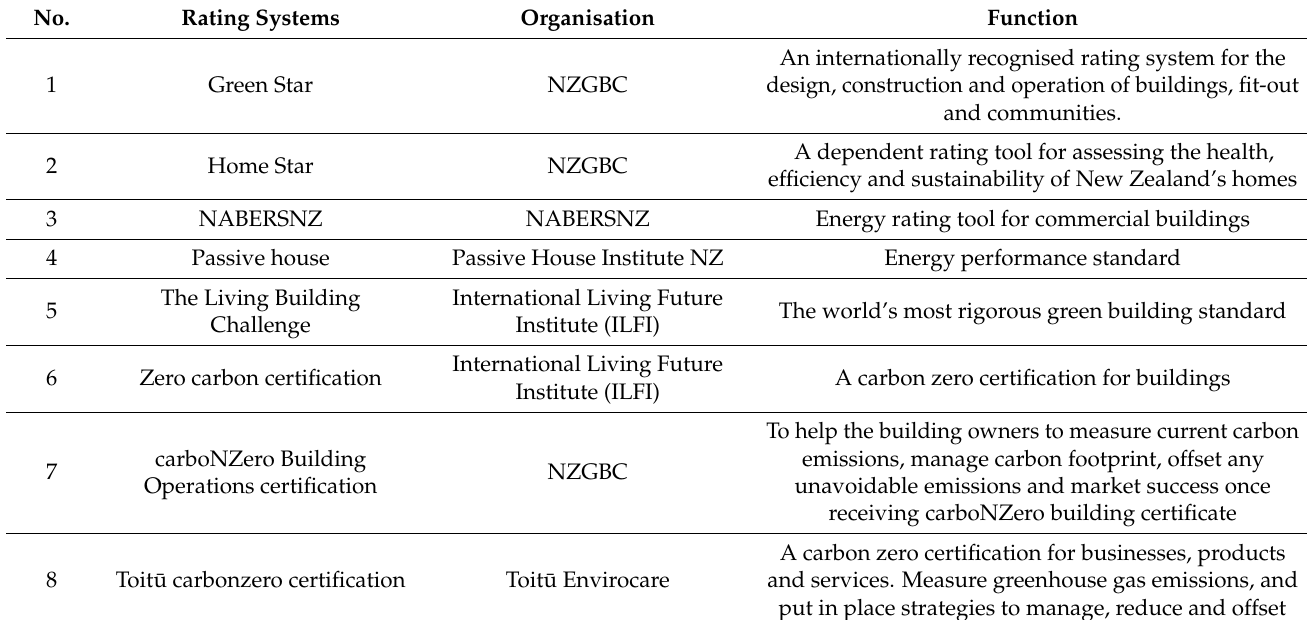
Table 3. Summary of rating tools used within the New Zealand construction